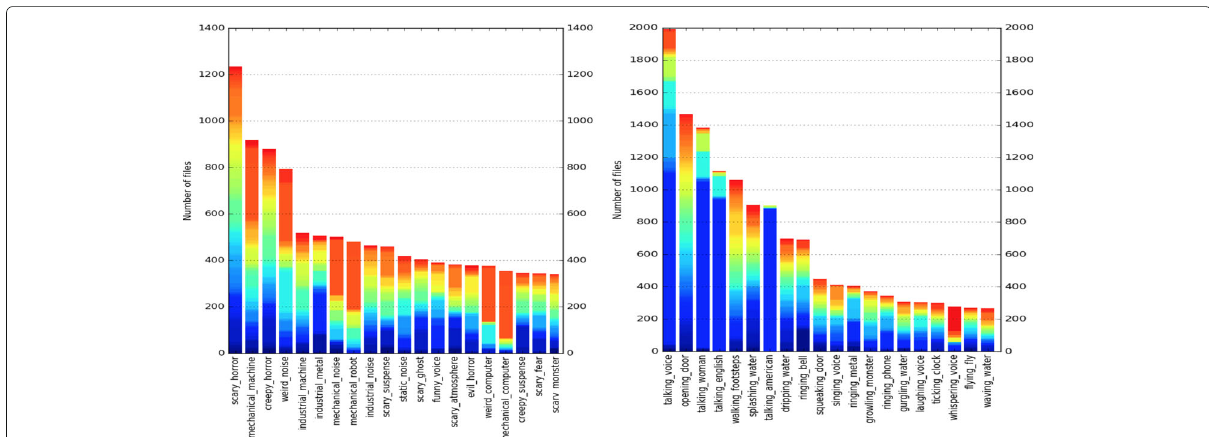
Fig. 6 Number of files per concept pair color-coded by the uploading users. ANPs (left) and VNPs (right) with the highest number of contributors (up to 400). Each user that contributed to a concept pair is color-coded. Most concept pairs are diverse, but a few may have dominant users